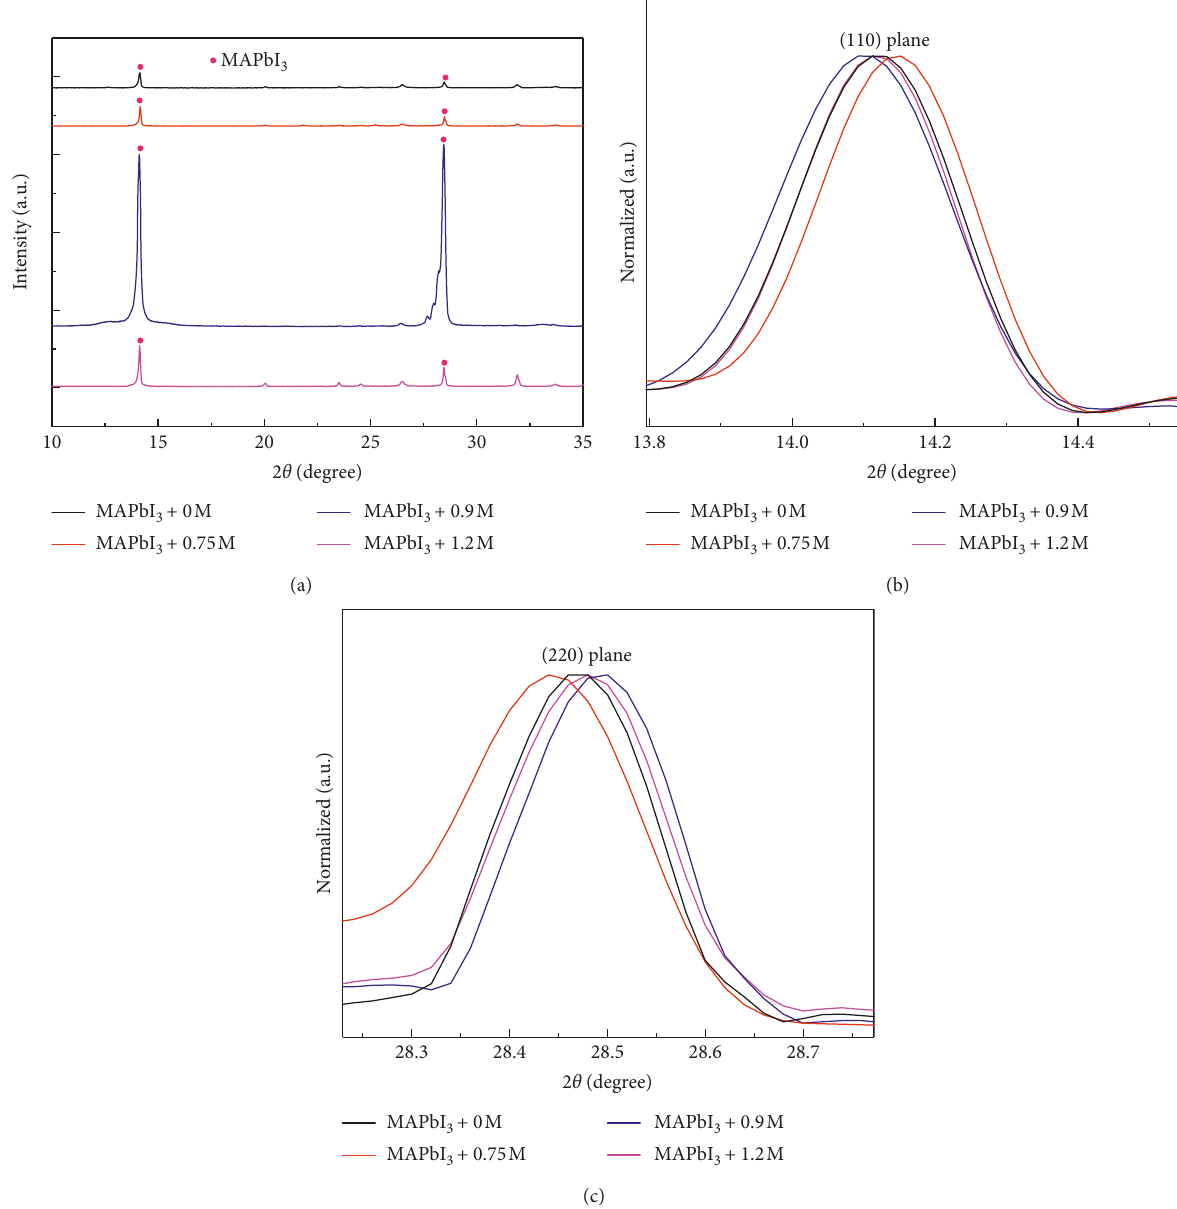
Figure 3: XRD patterns of perovskite films with Sample+0M, Sample+0.75M, Sample+0.9M, and Sample+1.2M: (a) whole patterns; (b) enlargement of (110) crystal plane; (c) enlargement of (220)